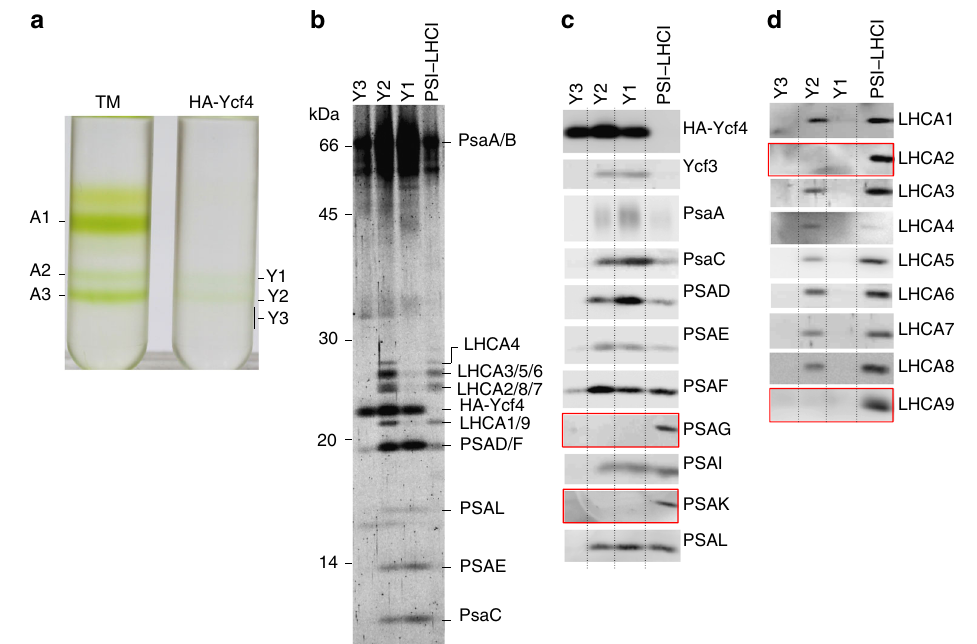
Fig. 5 Ycf4 oligomer assists the assembly of PSI core and PSI – LHCI subcomplexes. a SDG ultracentrifugation separated three chlorophyll – protein complexes, A1, A2, and A3, from WT thylakoid membrane extracts (TM) while two PSI assembly intermediates, Y1 and Y2, from the HA-Ycf4 preparation (see also Supplementary Fig. 6). Y1 and Y2 are green, whereas Y3 is colorless. The positions of Y1 and Y2 correspond to those of A2 (PSII core) and A3 (PSI – LHCI), respectively. b Polypeptides of Y1, Y2, and Y3, after concentration, were separated by SDS-PAGE and stained with Flamingo. c Immunoblotting of Y1, Y2, and Y3 with antibodies against Ycf3, Ycf4, and various PSI proteins. d Immunoblotting of Y1, Y2, and Y3 with antibodies against nine LHCI proteins. Red frames indicate the polypeptides that are present in PSI – LHCI but absent in Y1 and